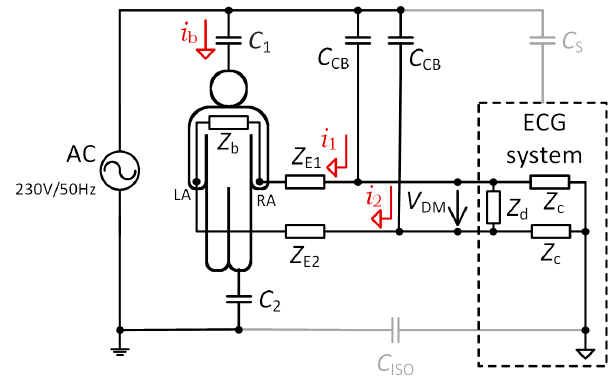
Figure 2. Power-line interference in the two-electrode ECG acquisition system emphasizing differential-mode interference.